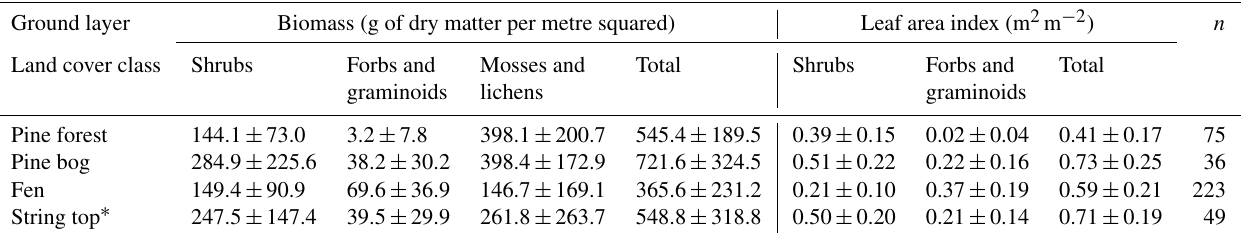
Table A1. Ground layer biomass and leaf area index (mean ± standard deviation) and the number of field measurement points.